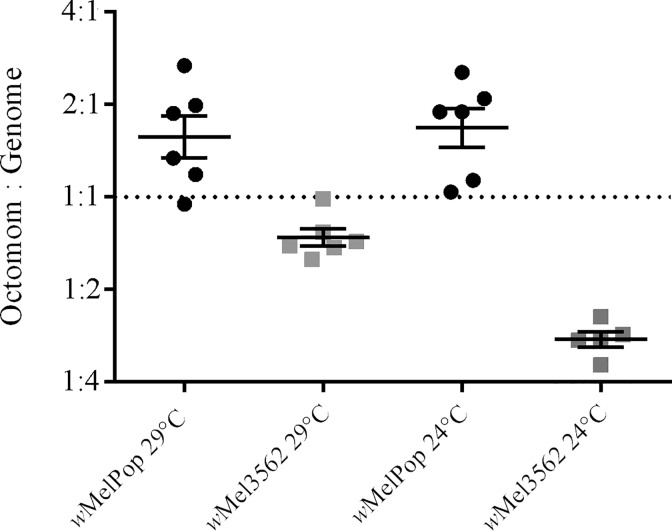
Octomom copy numbers in wMel3562 and wMelPop-infected flies.